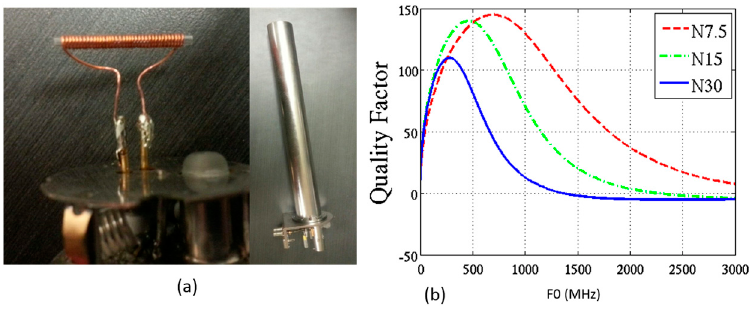
Figure 11. Experimental NMR ( a ) mini-coil connected to probe and a probe (300 MHz, Bruker) and ( b ) quality factor simulation results of mini-coil with different number of turns.